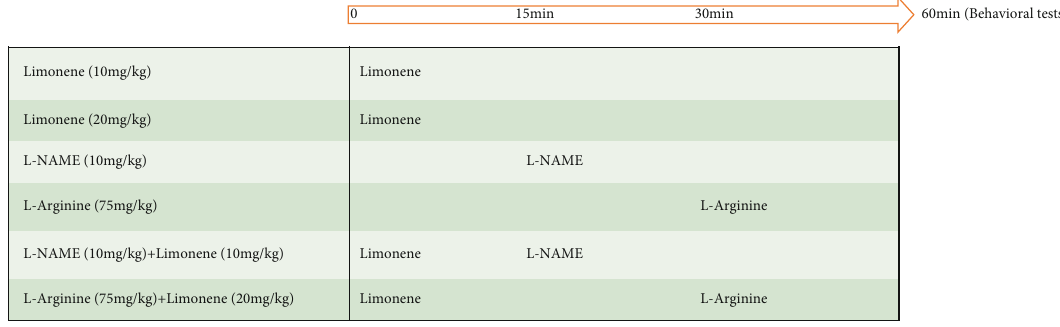
Figure 1: Schematic of the study design. Table 1: Primer sequences used in PCR ampli fi cation.